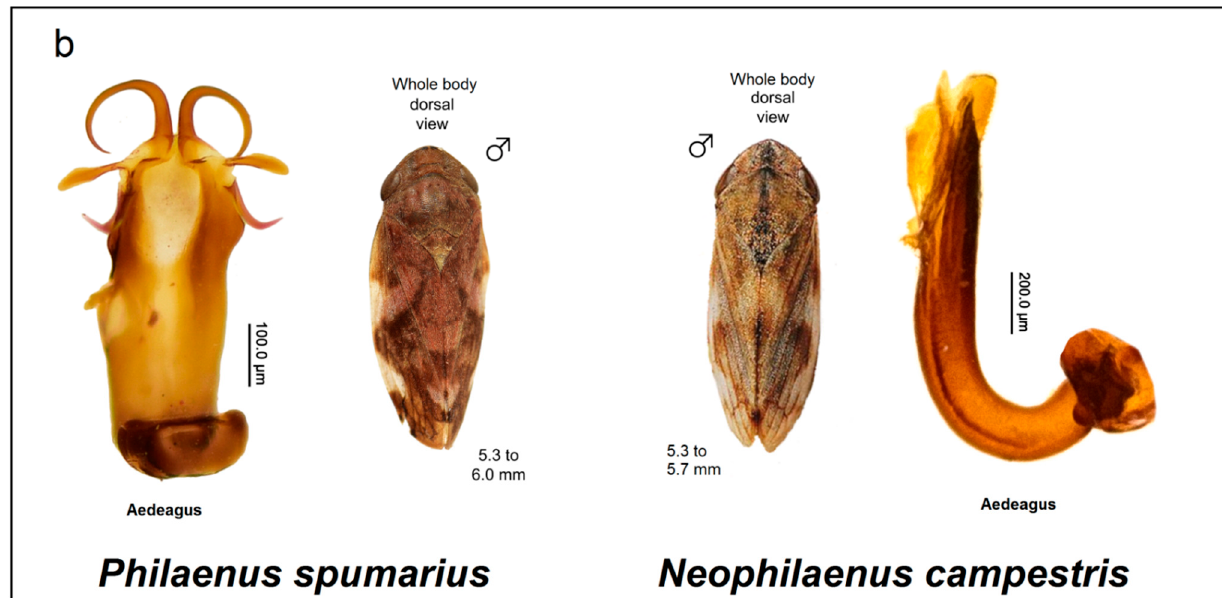
Figure 2. Morphological identification of the spittlebugs at the genus ( a ) and species ( b ) levels.